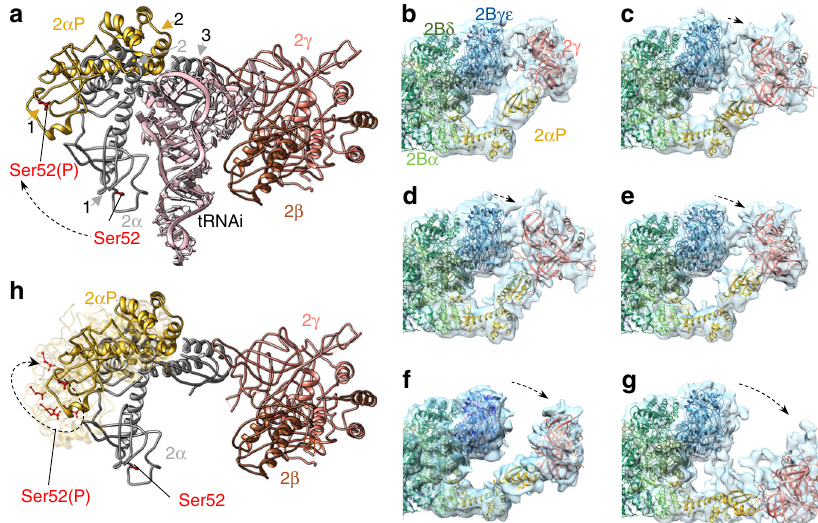
Fig. 2 eIF2 α conformational fl exibility on binding to eIF2B. a eIF2 α conformation differs between eIF2 α P/eIF2B and ternary complexes (TCs) complexes. eIF2 α from our eIF2 α P/eIF2B complex (domains 1 and 2 shown in gold and arrowed, domain 3 grey) aligned onto TC from 3JAP (2 α domains 1 – 3 in grey) using eIF2 α domain 3 as a reference. b – g Flexibility between eIF2 α domains 2 and 3 seen in eIF2 α P/eIF2B 3D classes obtained when halves of the particles were independently classi fi ed using a localised reconstruction script (described in the Methods section and Supplementary Fig. 2b). h eIF2 α P conformations from b – g aligned modelled onto 3JAP eIF2 (as in a ) as semi-transparent ribbons. Dashed black arrows indicate changed positions. In a , h , Ser52 and Ser52(P) side chains are shown in red